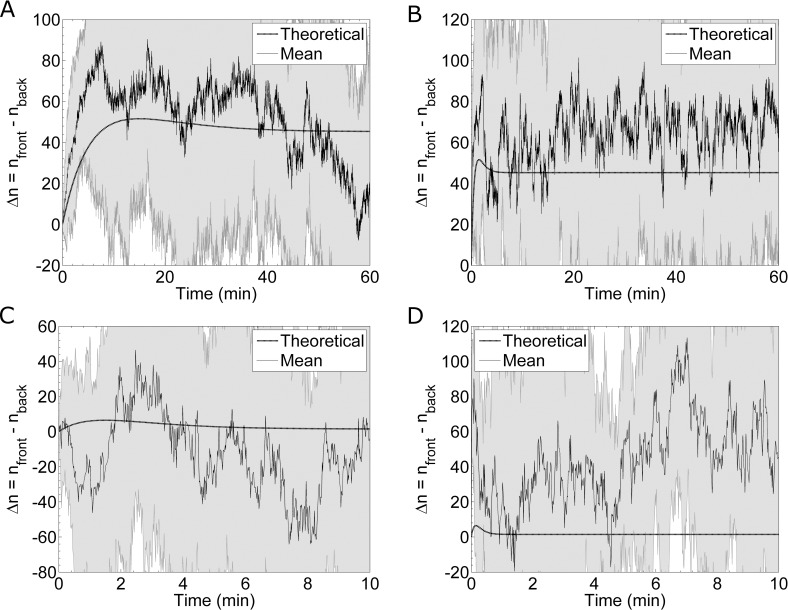
Transient Difference in Receptor Occupancy.Simulation results for the difference in receptor occupancy, Δn, between the front and back halves of a cell in a developing pheromone gradient of 0.1 nM/μm. The solid black lines are the mean Δn computed from simulations, and the shaded gray areas are the standard deviations from the means. The dashed black lines show the theoretical differences based on binding kinetics. (A) Results from twenty simulations of a system with slow binding kinetics in an average concentration of 6.9 nM. The theoretical curve is calculated using an average pheromone concentration of 6.775nM in the back half and 7.025nM in the front half. (B) Results from twenty simulations of a system with fast binding kinetics in an average concentration of 6.9nM. (C) Results from eight simulations of a system with slow binding kinetics in an average pheromone concentration of 69 nM. The theoretical curve is calculated using an average pheromone concentration of 68.875nM in the back half and 69.125nM in the front half. (D) Results from eight simulations of a system with fast binding kinetics in an average pheromone concentration of 69nM.